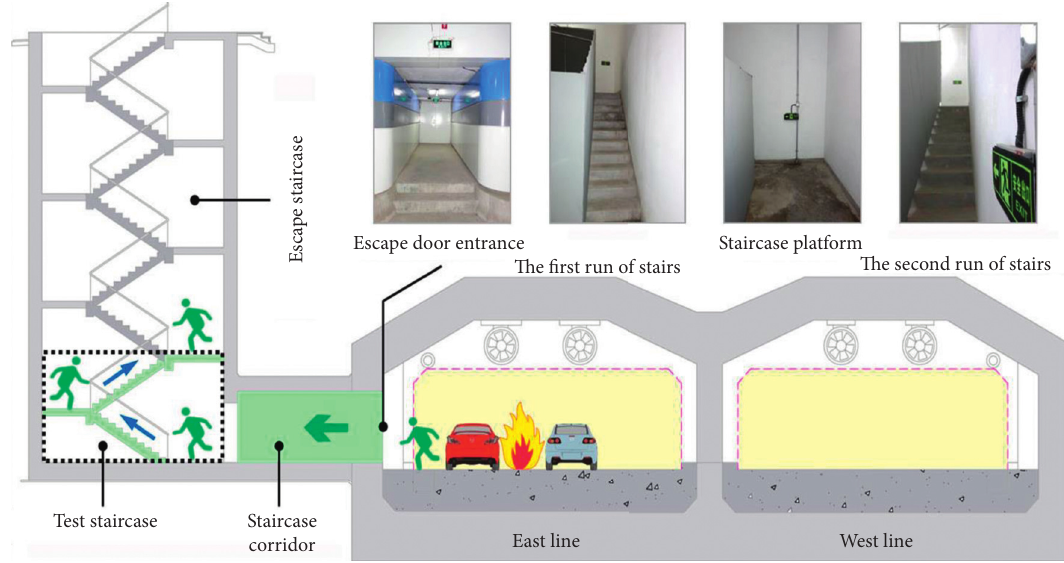
Figure 3: Form of escape staircase in the experiment. Table 1: Comparison between experiment escape staircase and the Nanjing Weisan Road Tunnel’s.